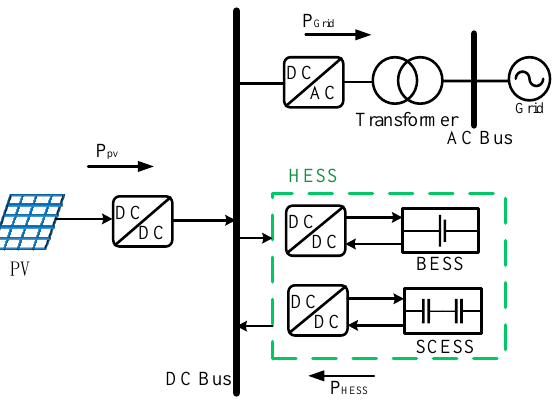
Figure 10. The schematic diagram of the PV power generation system equipped with